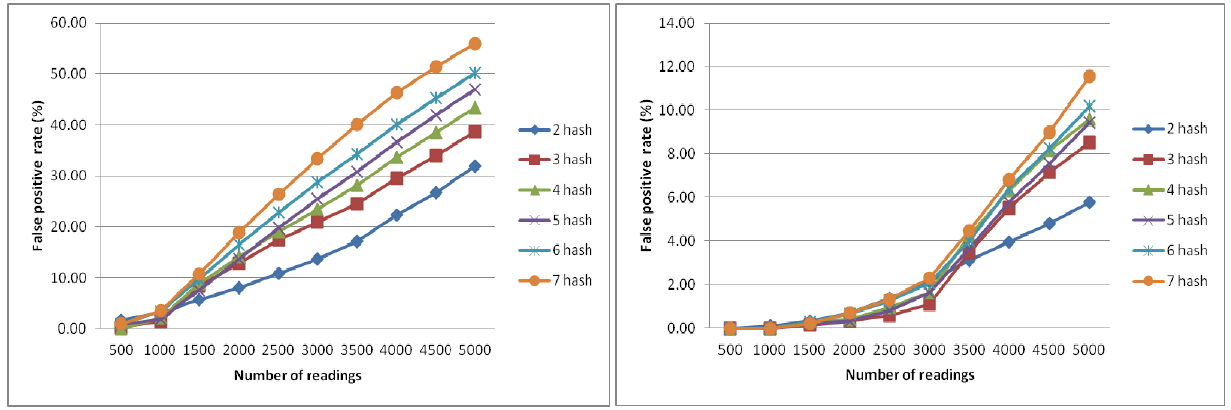
Figure 4. FPR of CBF as a functions k with counter size m = 5,000 ( left ) and m = 15,000 ( right